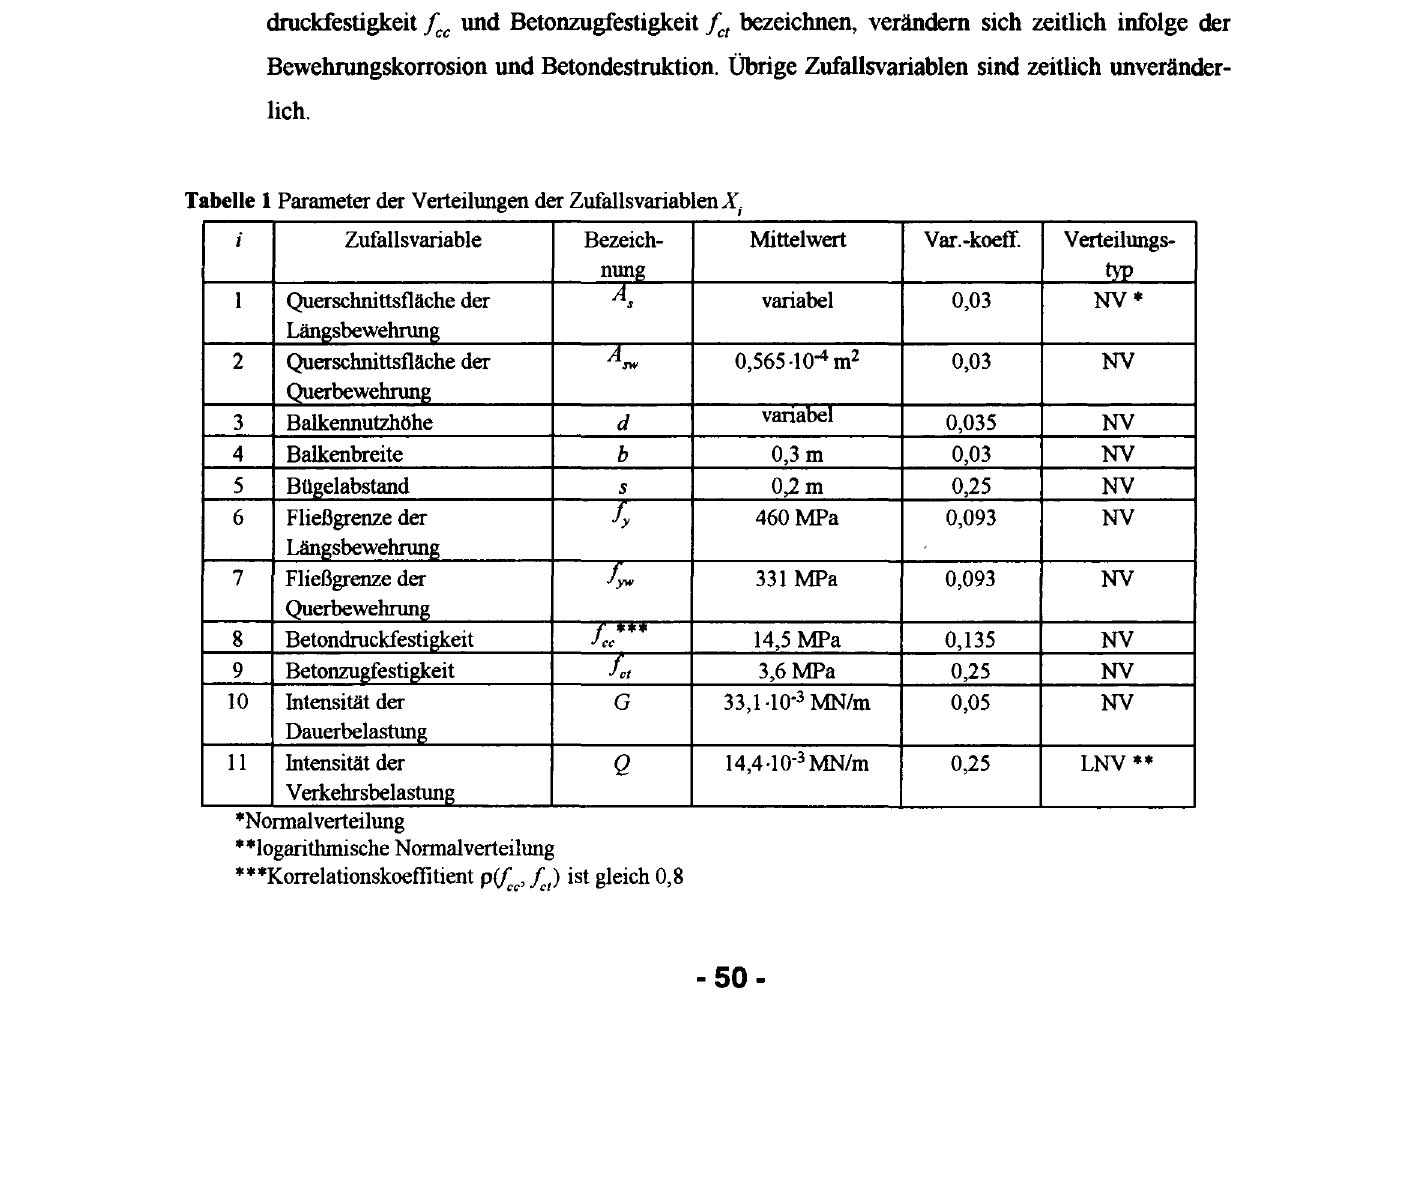
Tabelle 1 Parameter der Verteilungen der